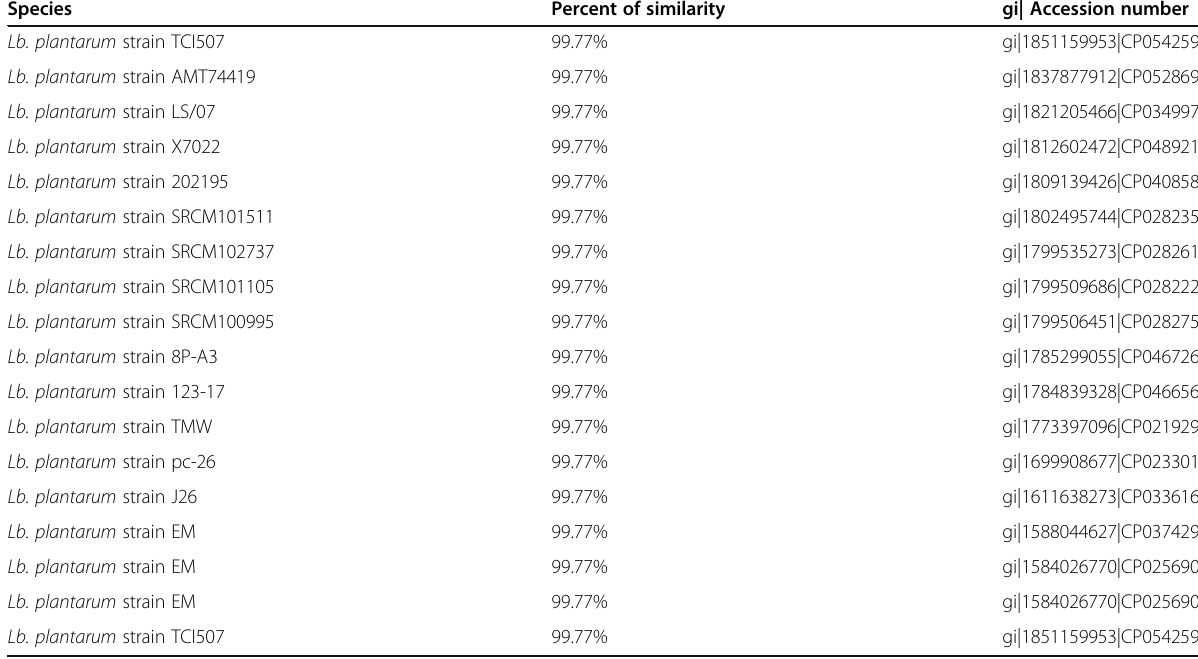
Table 2 Percent of the similarity of pln EF gene ( Lb. plantarum strain EG.LP.18.13)